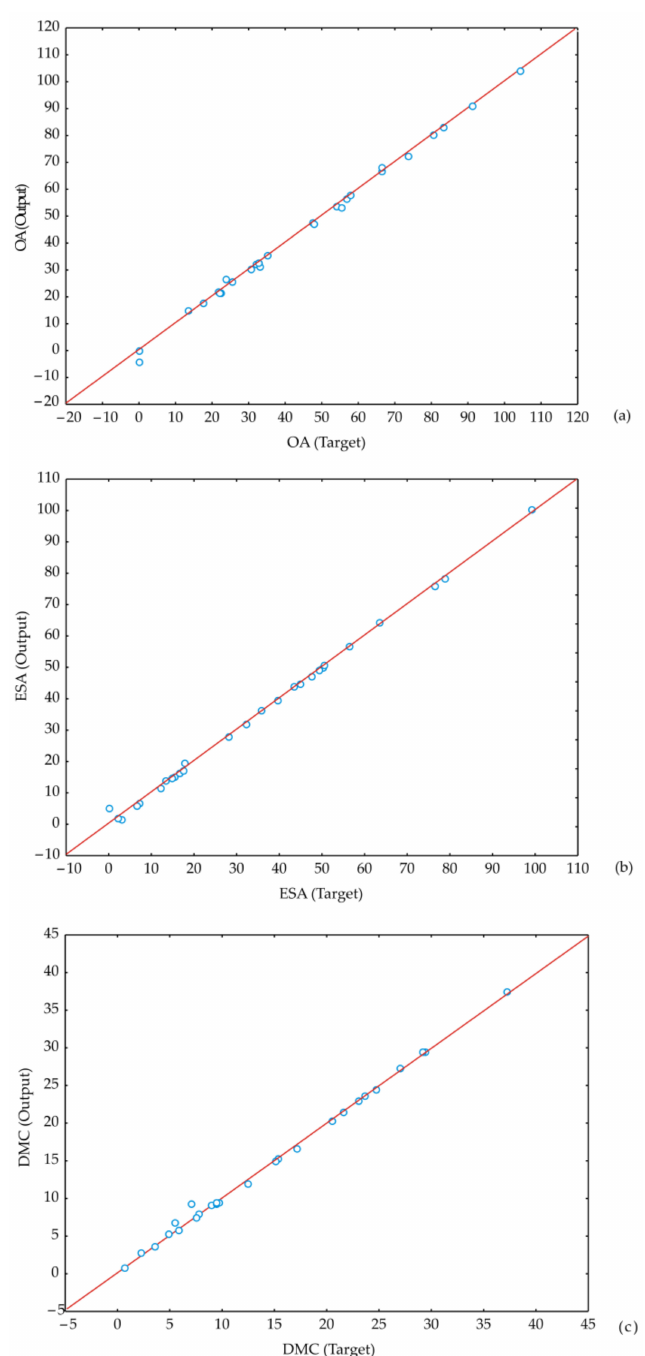
Figure 5. Comparison between experimentally obtained and ANN model predicted values of: ( a ) OA, ( b ) ESA, and ( c ) DMC. OA—dimethachlor oxalic acid, ESA—dimethachlor ethanesulfonic acid and